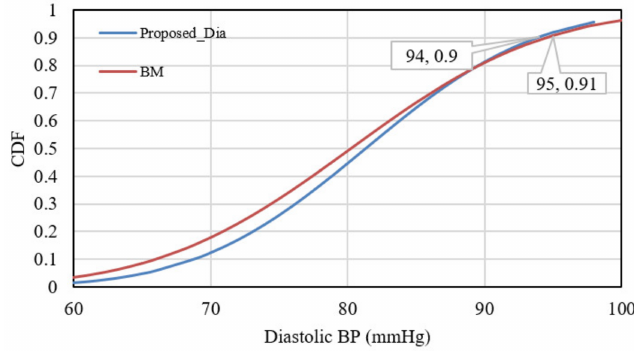
Figure 14. The CDF plot for diastolic BP measurements.